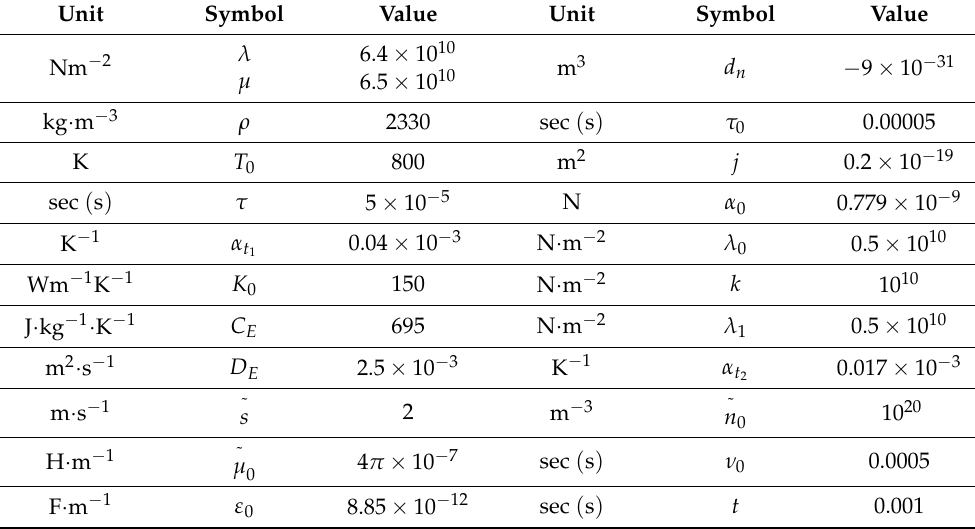
Table 1. The physical input parameters of Si medium in SI